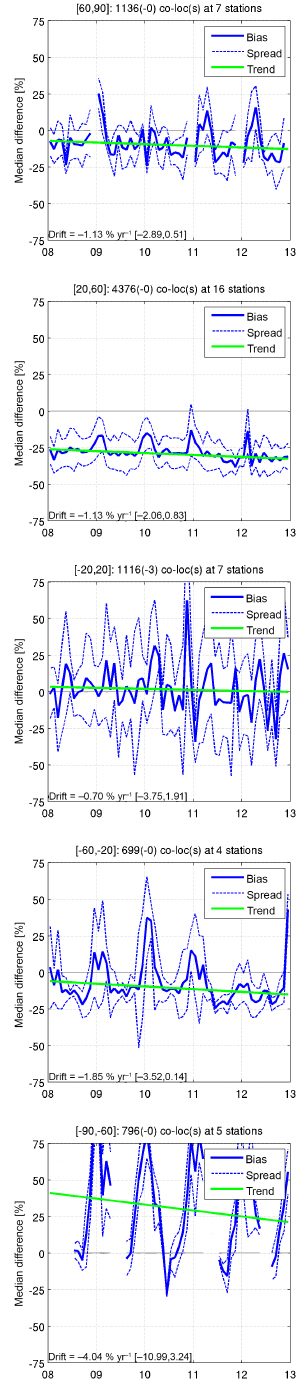
Figure 16. Time series of the median bias (solid blue), spread (dashed blue), and linear drift (green line) for direct comparisons of IASI L3 monthly gridded mean tropospheric ozone column data (0 to 6km) with vertically integrated ozonesonde reference data (at stations with at least six launches per month), divided into five lat- itude bands (sorted north to south). The number of filtered values is added between brackets in the title of each plot, while the yearly linear drift value and its 95% confidence interval are added in the lower-left